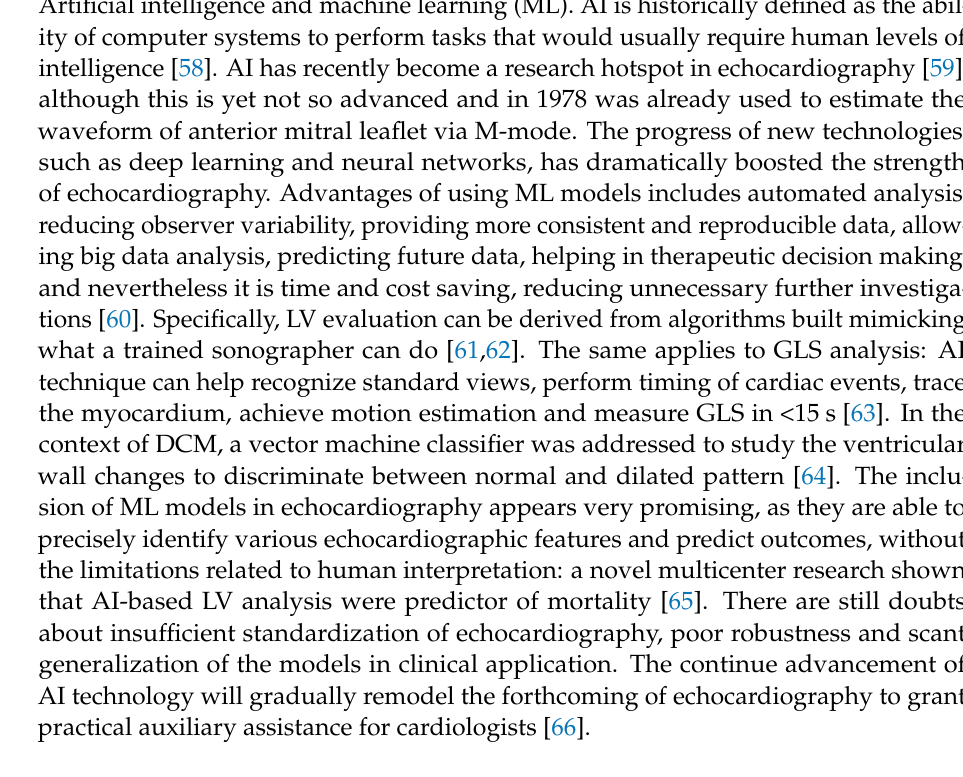
AP3 Deform. long. = −5.2% AP4 Deform. long. = −5.4% AP4 Deform. long. = −6.6% Globable Deform. long= −5.7%